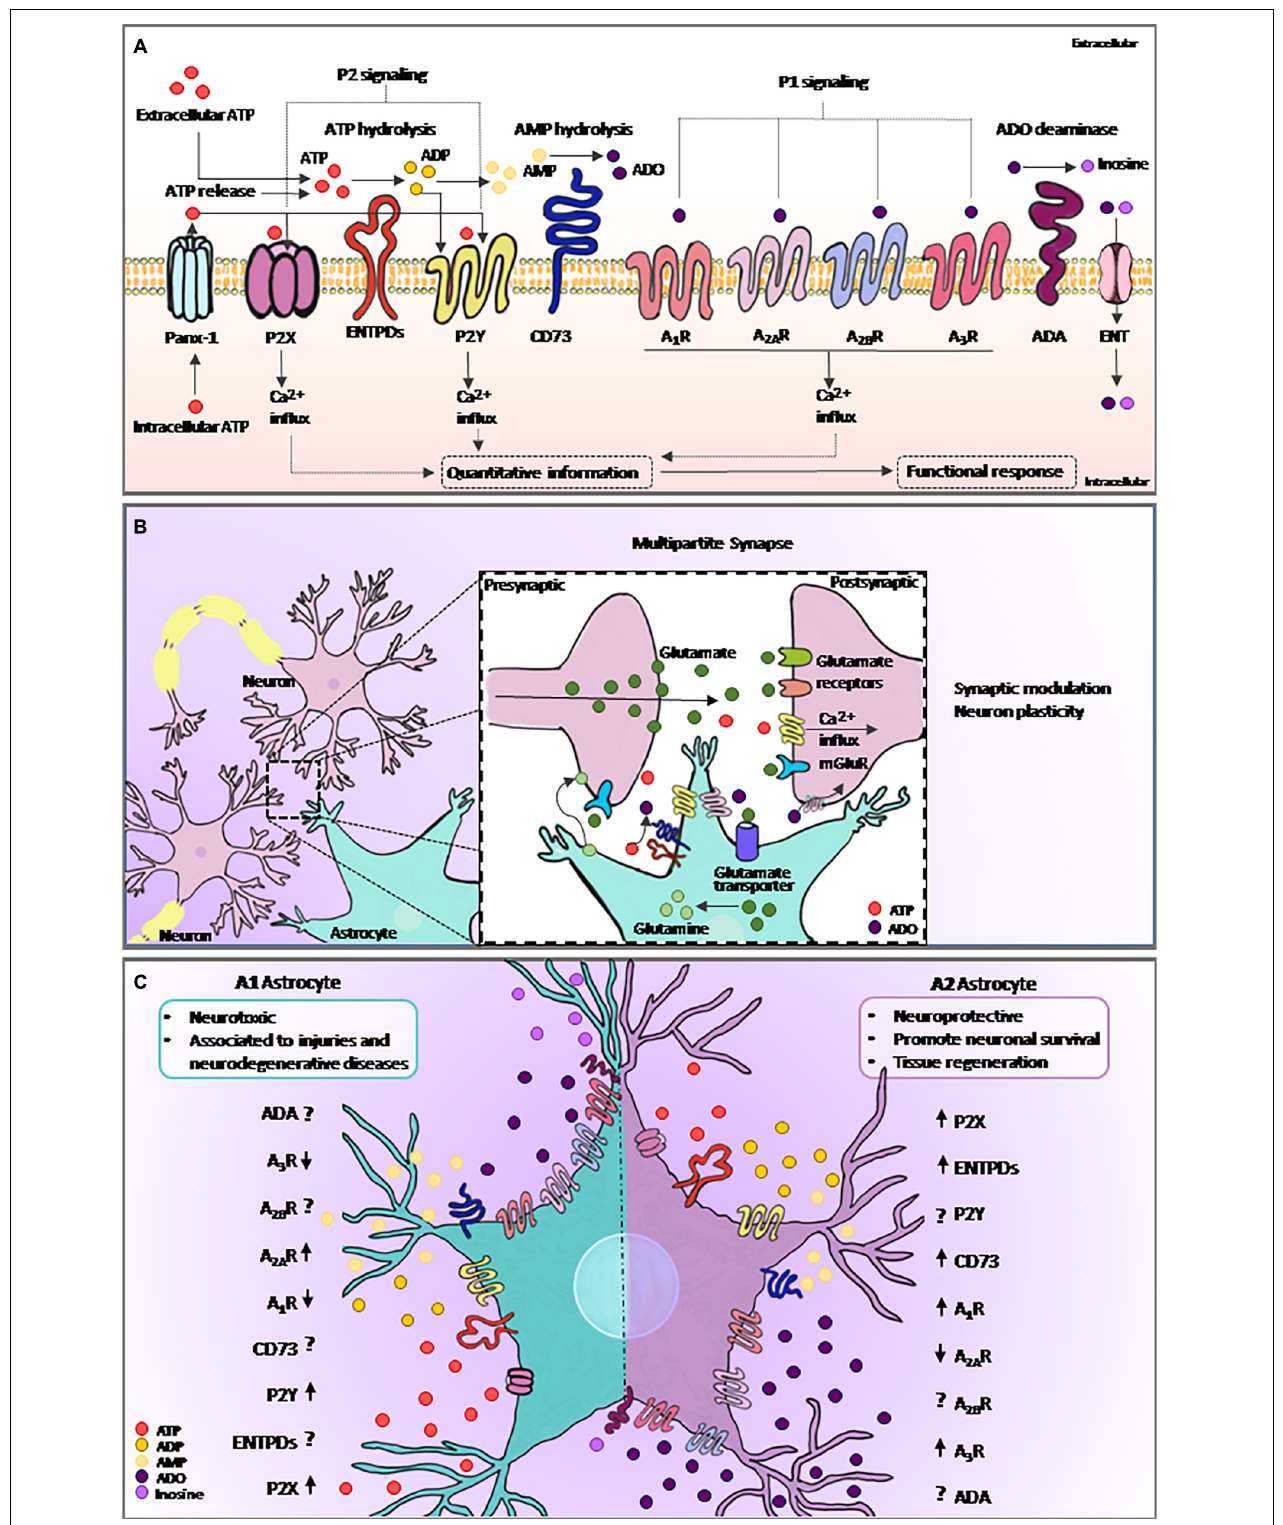
FIGURE 2 | Purinergic signaling and astrocytes. (A) Intracellular ATP is released from astrocytes via specific channels such as Panx-1. Extracellular ATP and its breakdown products, ADP and ADO, are agonists of purinergic receptors, and the extracellular levels of nucleotides and nucleosides are regulated by